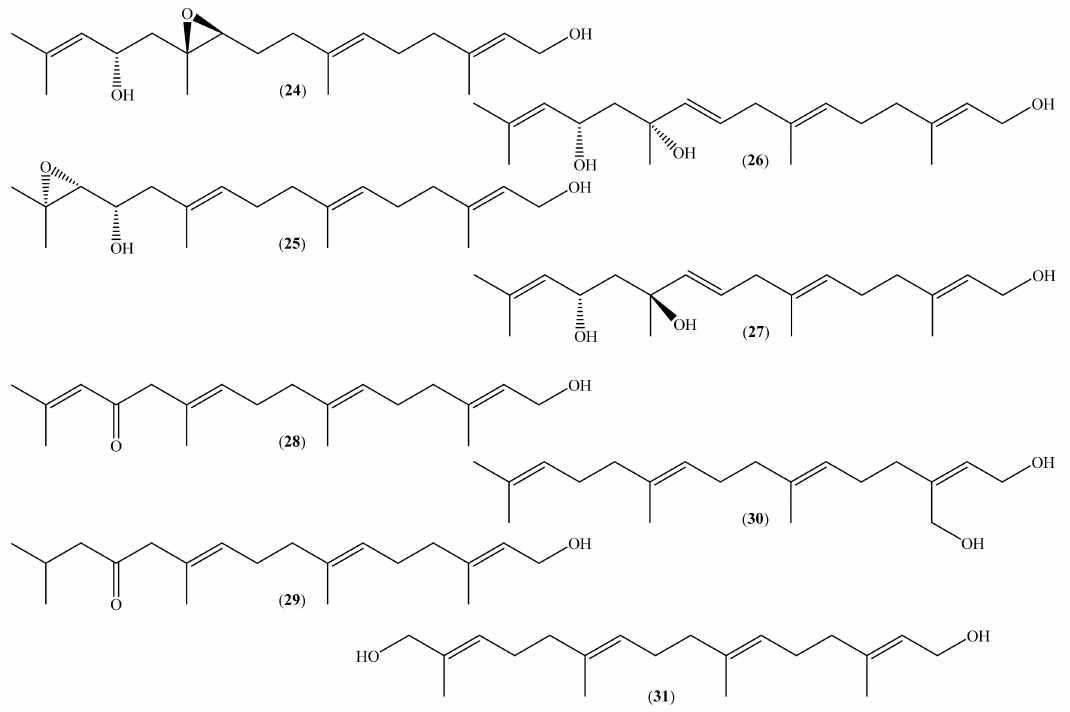
Figure 3. Chemical structure of linear diterpenes isolated from marine organisms.